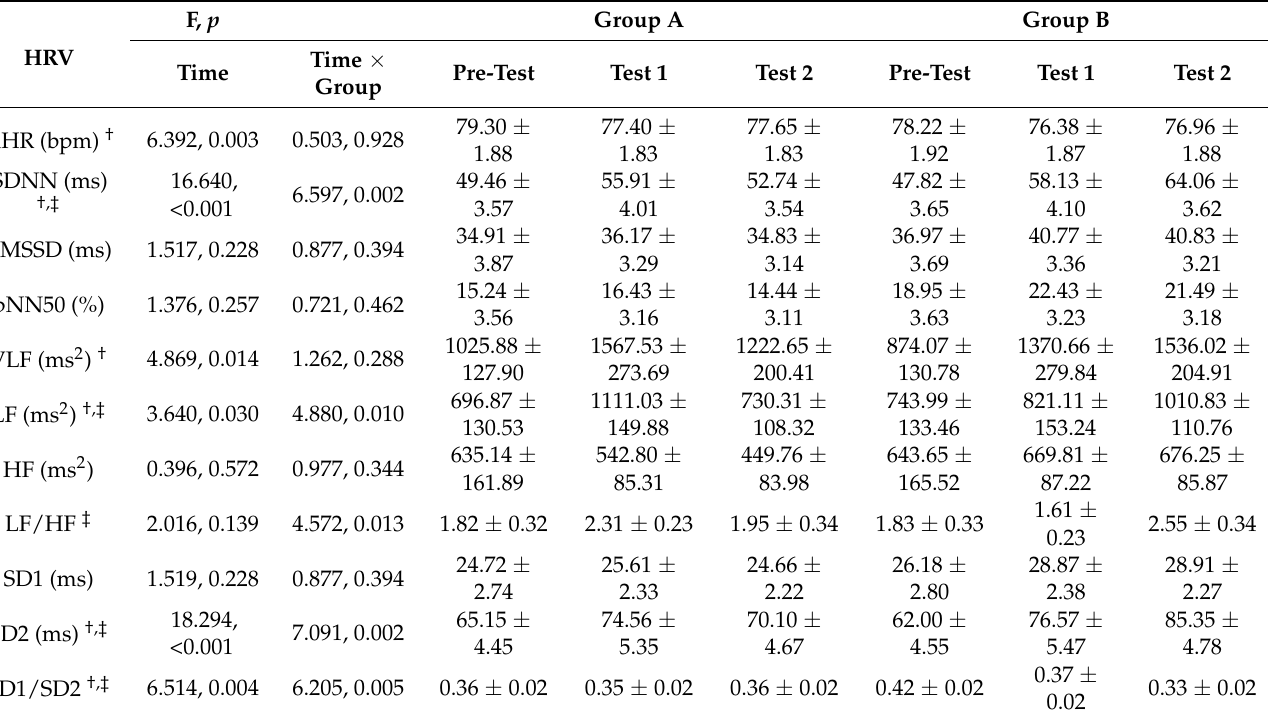
Table 2. A repeated-measures ANOVA results on the heart rate